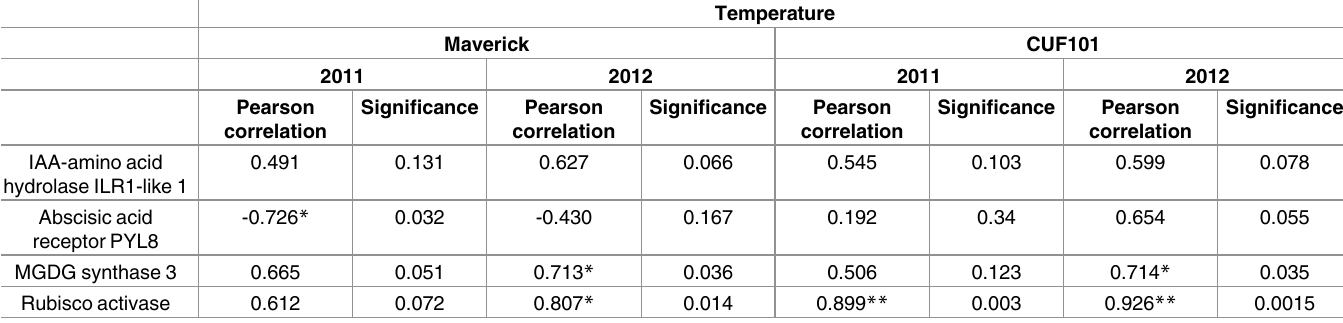
Table 4. Correlation between mRNA abundance in the leavesof Maverickand CUF101varietiesand temperature in 2011 and